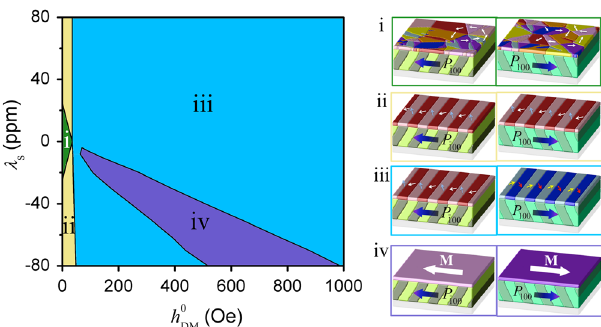
Fig. 4 Diagram showing four different types of electrically driven magnetization switching in magnetic/BiFeO 3 heterostructures, including (i) no stripe domain, (ii) domain pattern exchange, (iii) net magnetization reversal, and (iv) uniform magnetization reversal. The switching type depends on the magnitude of ) and the saturation magne- Dzyaloshinskii – Moriya interaction ( h 0 DM tostriction ( λ s ). Shown on the right are the typical magnetic and ferroelectric domain structures before and after electrically switch- ing the in-plane polarization ( P 100 ) in the BiFeO 3 layer. The arrows indicate local magnetization directions. Adapted with permission.